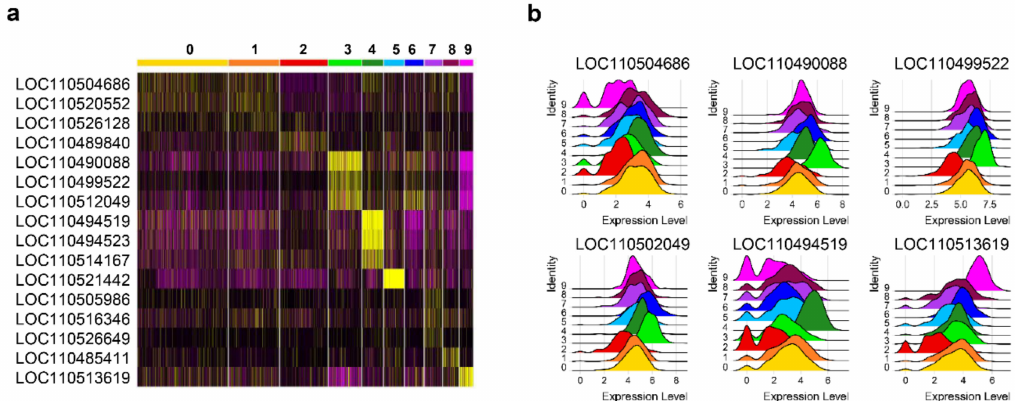
Figure 6. Long non-coding RNAs (lncRNAs) identified as markers for different cell clusters. ( a ) Heatmap showing the most significant lncRNAs with differential expression between clusters. ( b ) Ridge plot showing normalized expression in each cluster of lncRNAs identified as markers for specific